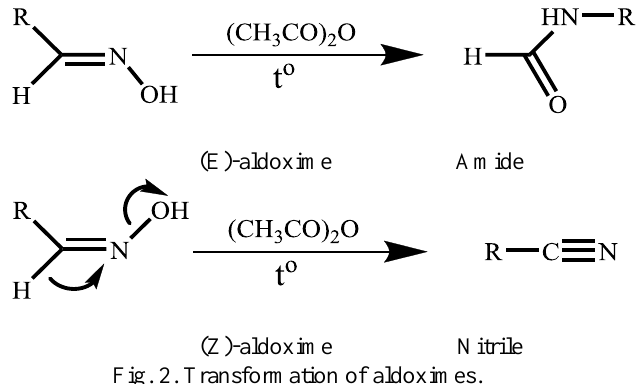
Fig. 2. Transformation of